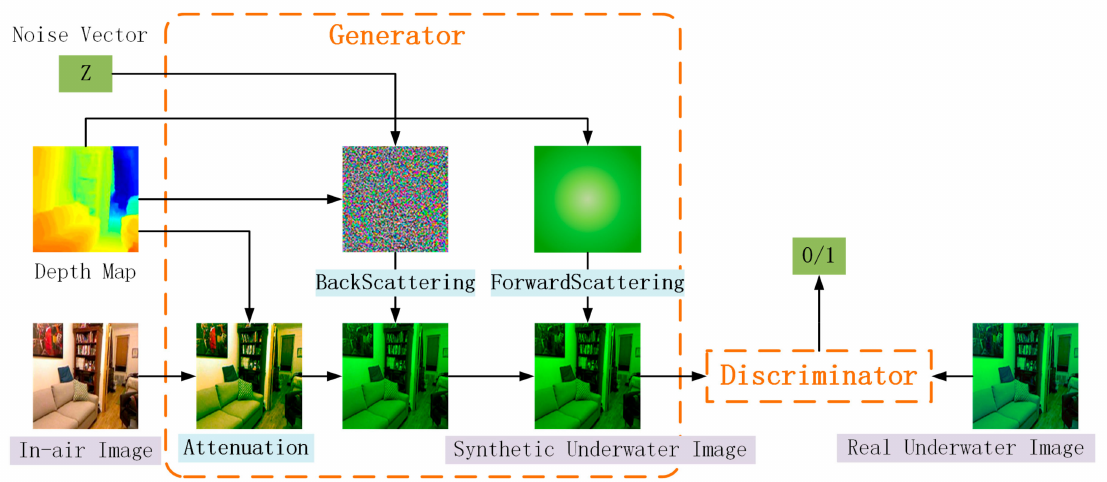
Figure 3. UWGAN architecture. UWGAN takes in-air images and its depth maps as input; then, it synthesizes underwater degraded images on the basis of underwater optical imaging model by generative adversarial